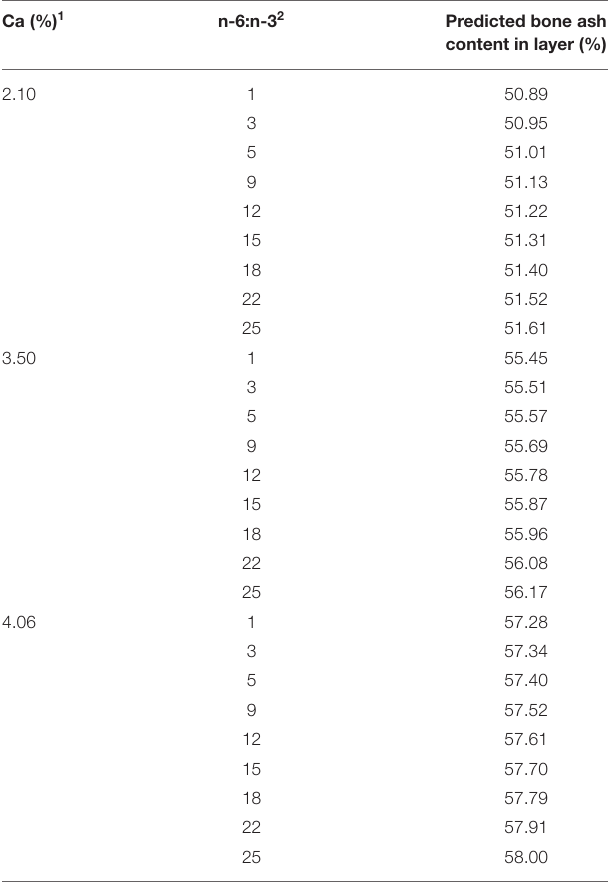
TABLE 4 | Predicted BAC (%) for layers using the developed model, where BAC (%) = 44.01 + 0.03 (dietary n-6:n-3) + 3.26 (Ca concentration diet, %). Ca (%) 1